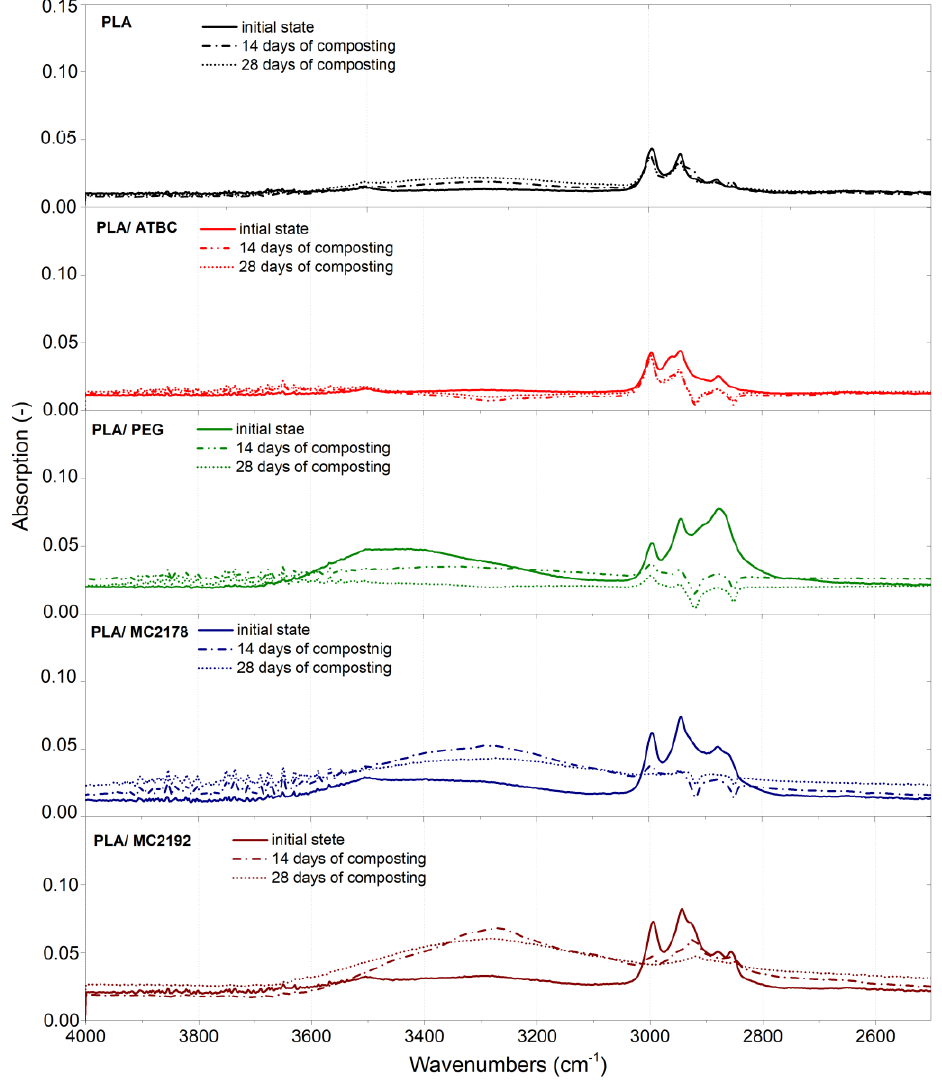
Figure 17. FTIR spectra of as-produced PLA films at initial state and after 14 days and 28 days of thermophilic composting that indicate hydroxyl bands.